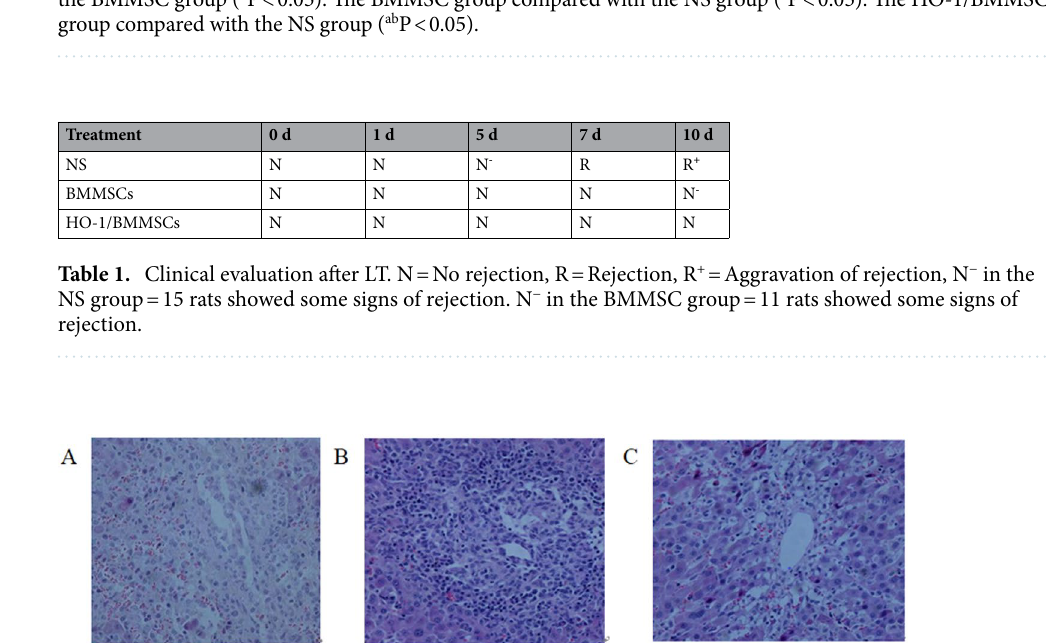
Figure 3. Pathological findings of LT in each group (×100). ( A ) NS Group. ( B ) BMMSC group. ( C ) HO-1/ BMMSC